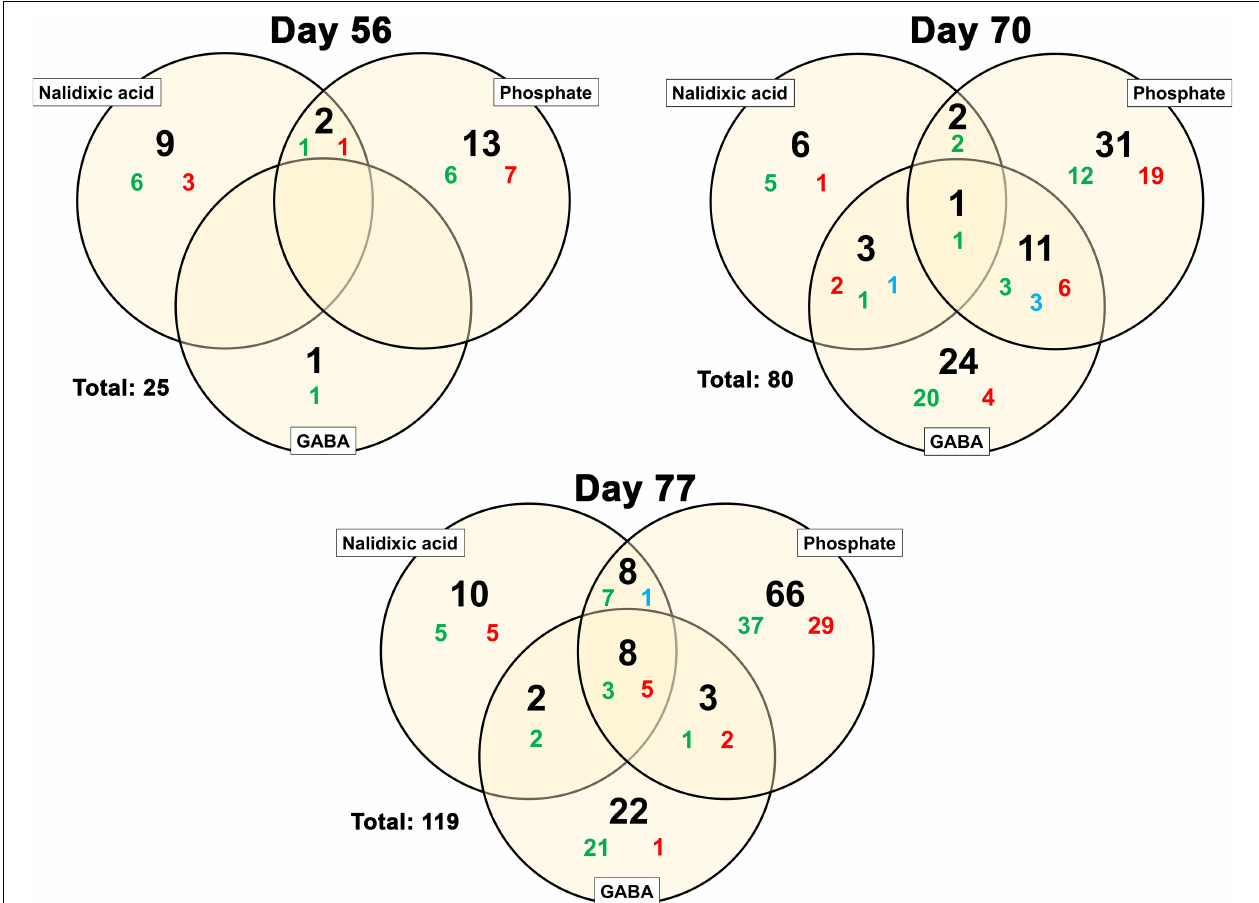
FIGURE 6 | Venn diagrams for genera exhibiting a dynamic behavior in comparison with the control in all reactors: Significant changes in frequency are shown for all the days where DNA samples were analyzed (day 56, 70, and 77). Genera showing an increase in relative abundance are highlighted in green. Genera exhibiting a decrease are highlighted in red. In some cases, the relative abundance of a genus was significantly increased by one stressor but significantly decreased with another stressor. Such cases are highlighted in blue. The sum of all changes (blue, red, and green) is given in black. The total number of OTUs, which were significantly affected in all the reactors is shown to the left of each diagram. Genera from each reactor were compared with the control and only results with a significance of p < 0.05 were